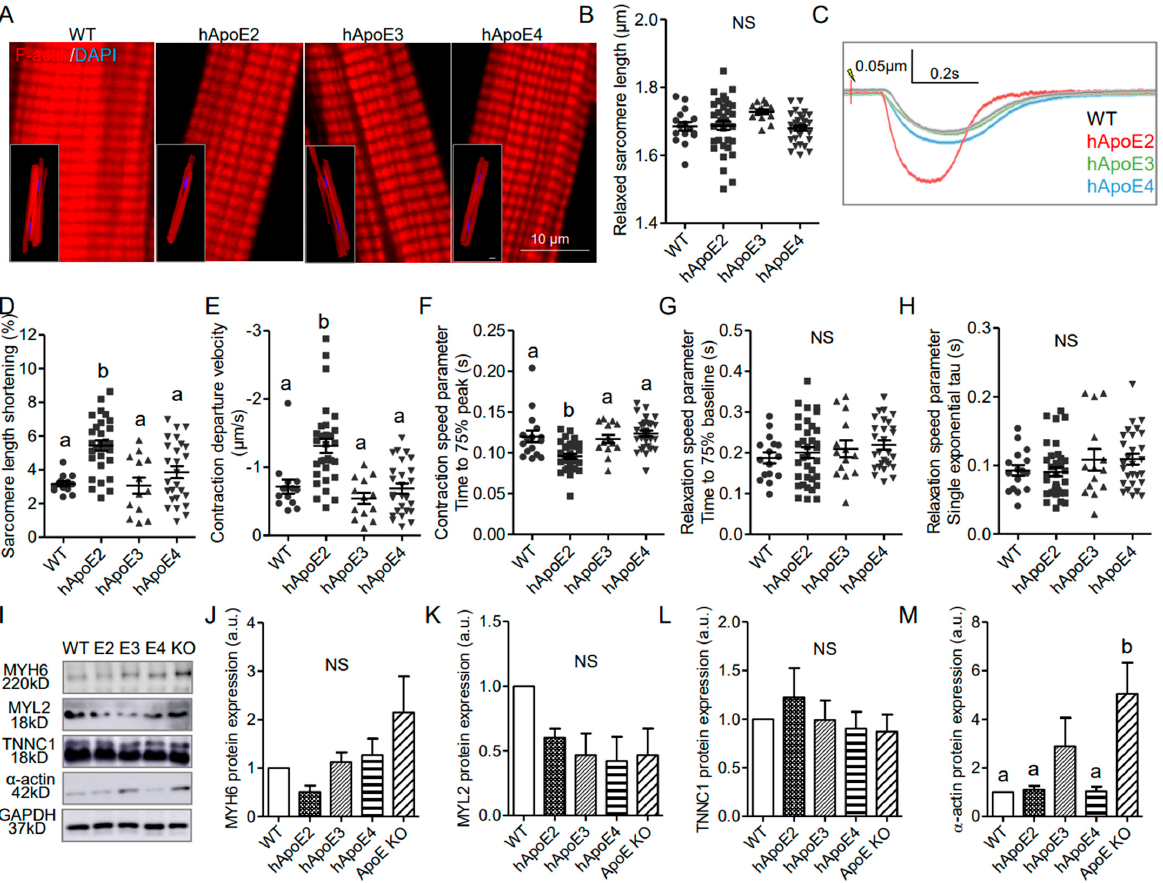
Figure 3. Isolated adult hApoE2 cardiomyocytes showed stronger cellular contractility, which is not due to the mechanisms regulating actin and myosin filament assembly. ( A ) DyLight TM 554 Phalloidin stained the F-actin labeling the thin filaments (red) of the cardiomyocytes isolated from adult rats. Nuclei were stained by DAPI in blue. ( B ) The relaxed sarcomere length of isolated adult cardiomyocytes was compared. ( C ) Representative traces of sarcomeric contractions are shown. Isolated cardiomyocytes were stimulated by 5 to 8 volts pacing stress at 1 Hz. ( D ) Percent change of sarcomere length during the contraction was compared between cell groups. ( E ) The departure velocity, a value indicating the maximal rate of change during the contraction, was compared. ( F ) The time to 75% of maximal departure velocity indicating how fast contraction happened was compared. ( G ) The time to 75% baseline, representing the time that sarcomere restored 75% of length change between the shortest length after stimulation, and initial baseline length were compared (noting that the sarcomere may not back to the baseline length during the relaxation phase). ( H ) The single exponential tau, the exponential decay time constant of the function, as another means of characterizing the speed of relaxation, was compared as well. A greater tau value means a longer relaxation time. ( I – M ) Western blotting was applied to detect the expression levels of cardiac myosin heavy chain (anti-MYH6), myosin light chain (anti-MYL2), troponin C (anti-TNNC1), and the thin filament protein α -actin in heart lysate of different adult rats. Glyceraldehyde 3-phosphate dehydrogenase (anti-GAPDH) was used as a loading control. One-way ANOVA followed by a Tukey post hoc test. a vs. b, p < 0.05, NS, no significant difference. Cells indicated by symbols were from three rats per group. Three to five rats per group were used for Western blotting